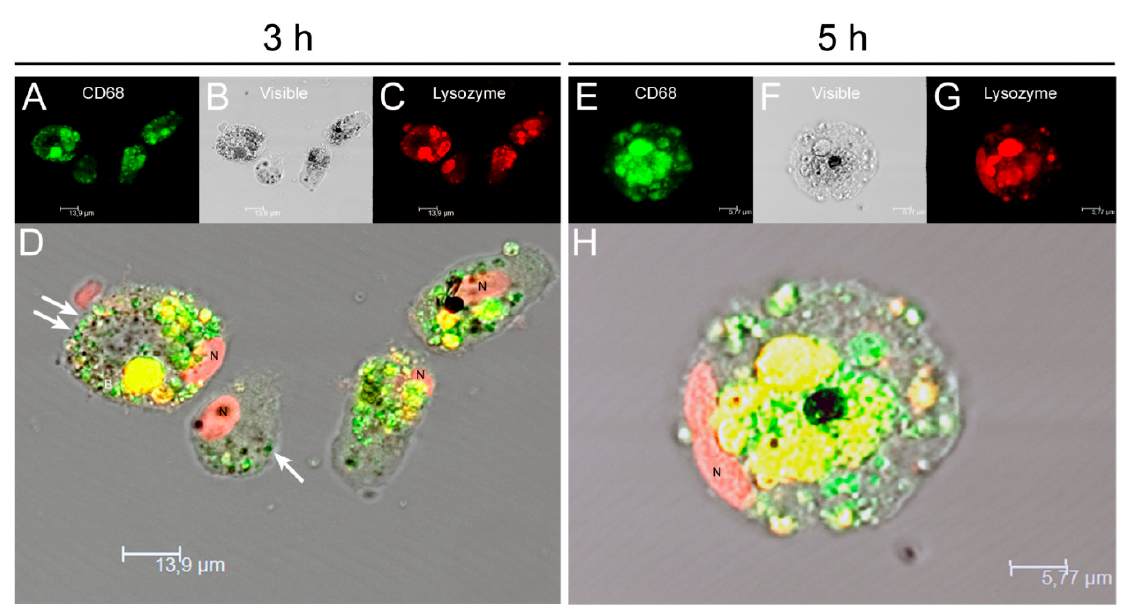
Figure 2. Internalization of L. infantum parasites by canine KCs. After 3 h ( A – D ) and 5 h ( E – H ) of exposure to L. infantum GFP amastigotes (white arrows), KCs were stained for CD68 (green), lyso- zyme (red) and nucleus (N) and fluorescent and visible light images were acquired. Co-localization of CD68 and lysozyme in lysosomal compartments (yellow) can be observed in overlapping images ( D , H ). CD68 and lysozyme accumulation can be noticed at 5 h of parasite exposure ( H ).